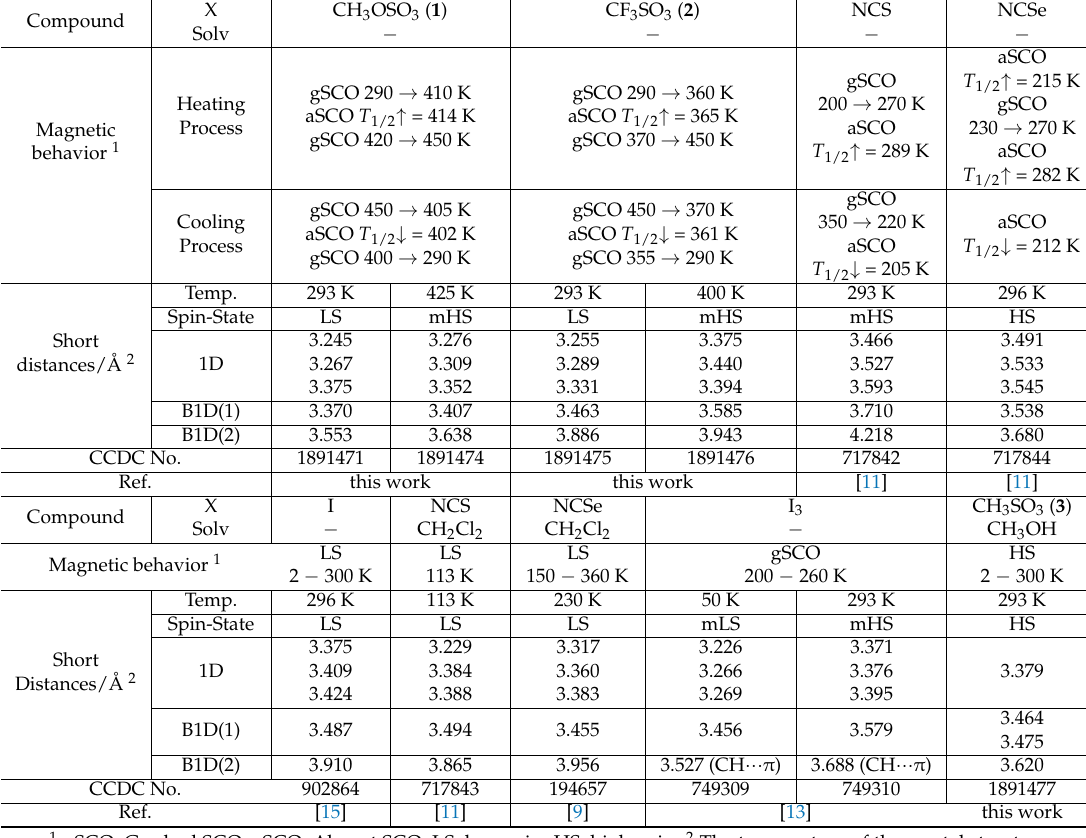
Table 9. Magnetic behaviors and selected intermolecular short C ··· C distances between the [Fe(qsal) 2 ] cations for [Fe(qsal) 2 ](X) ·